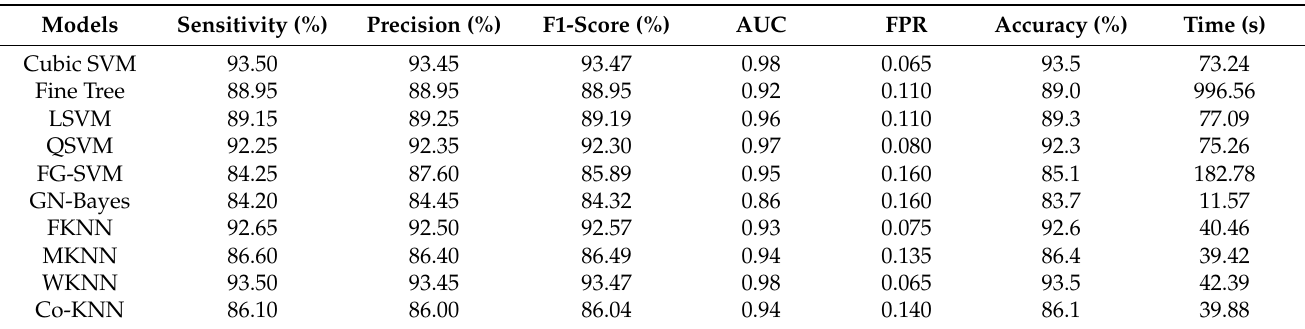
Table 5. Classification results using MEWOA Nasnet Mobile deep features for